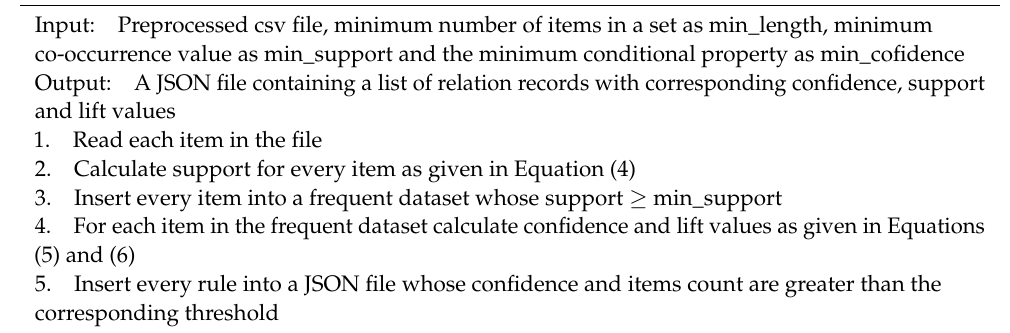
Algorithm 3 TREASURE Relation Records Generation via Affinity Analysis